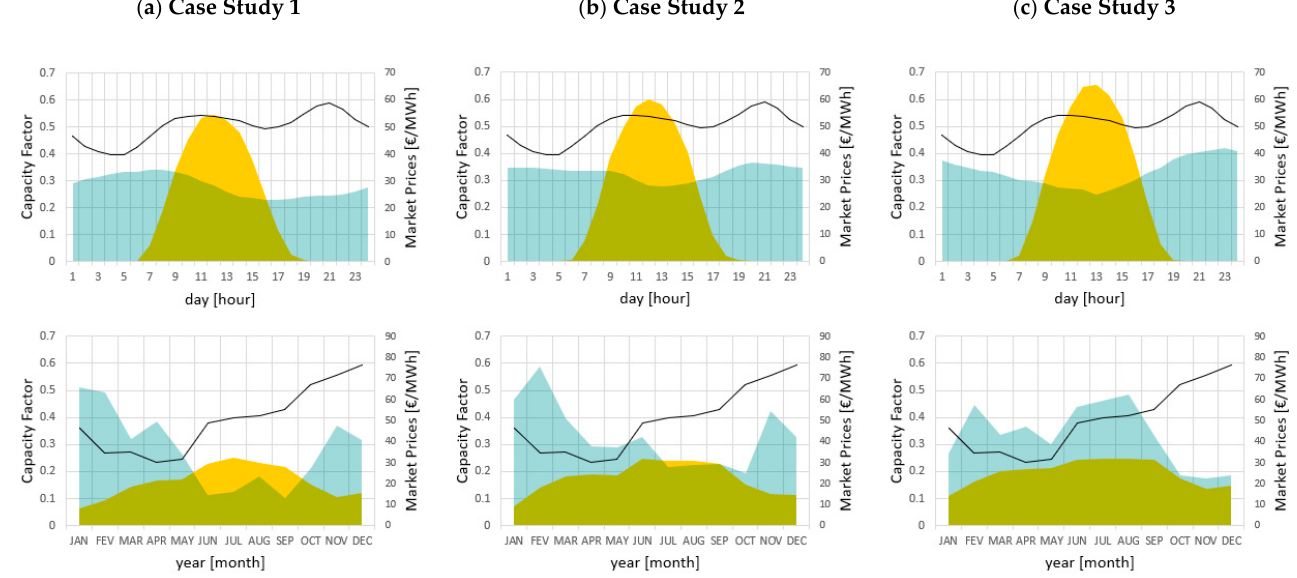
Figure 5. Daily ( top ) and annual ( bottom ) average capacity factor for the wind and PV technology in the selected case studies.